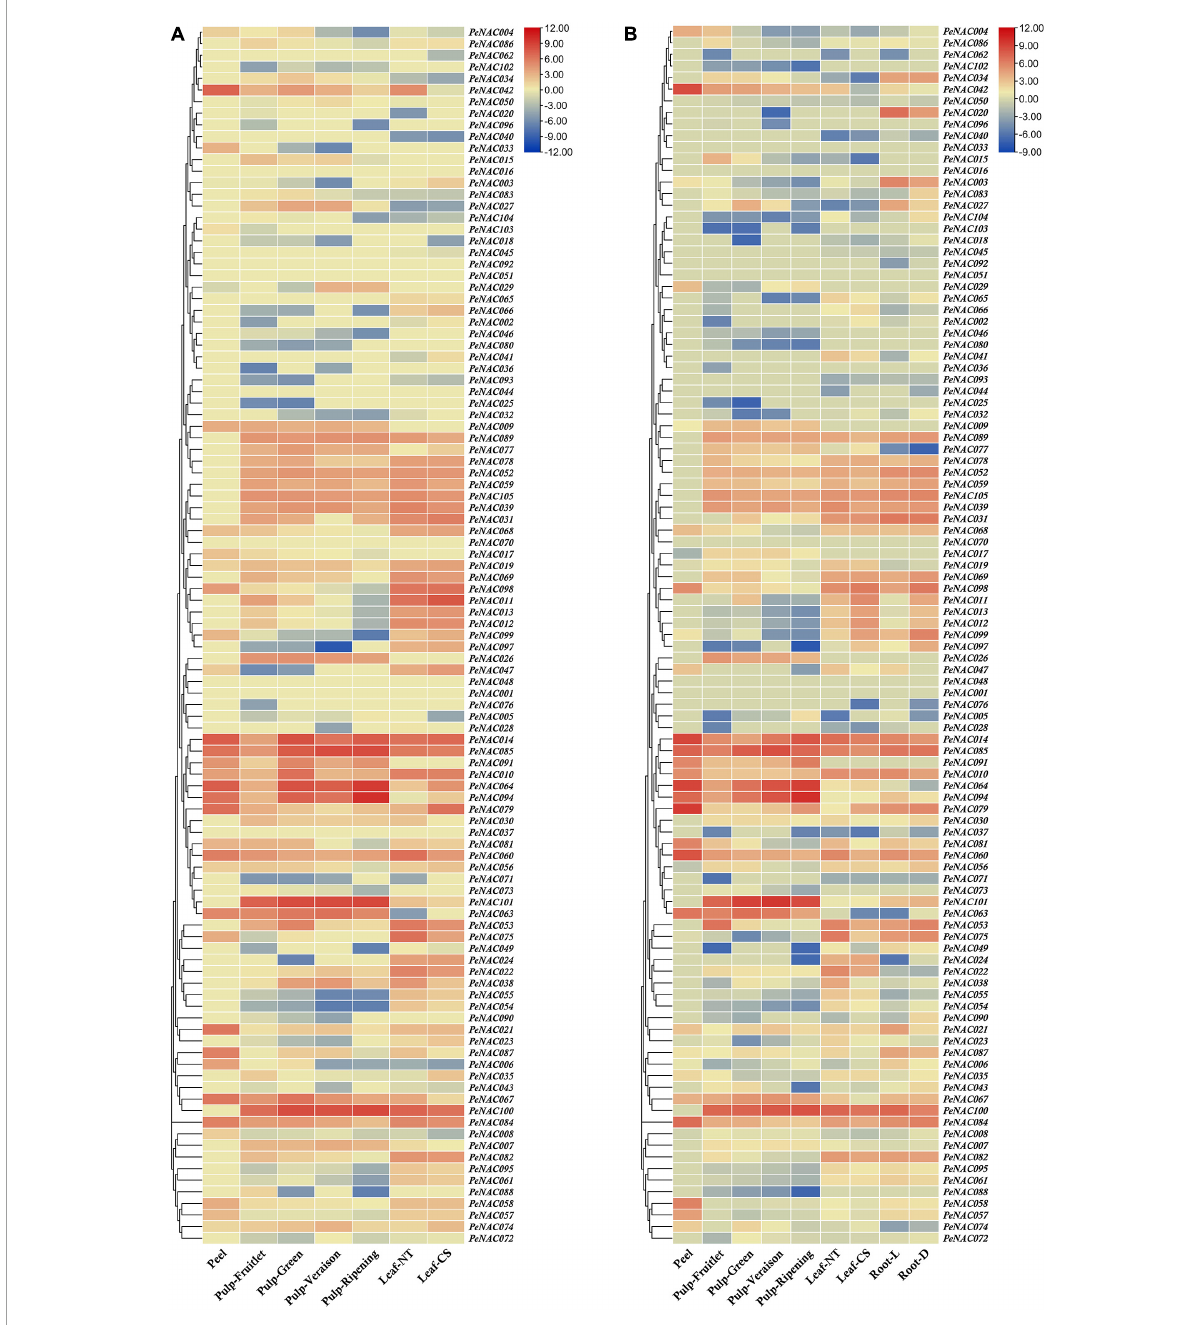
FIGURE10 The heatmap showing the expression profiles of PeNAC genes in pulp, root, peel, and leave tissues of yellow and purple passion fruit cultivars under different conditions. (A) PeNAC expressions in the peel, pulp (Fruitlet, Green, Veraison, and Ripening stages) and leaf (NT and CS) of yellow passion fruit. (B) PeNAC genes expressions in the peel, pulp (Fruitlet, Green, Veraison, and Ripening stages), leaf (NT and CS) and root (L and D). The NT and CS indicate the normal temperature (NT) and chilling stress (CS) conditions. L and D represent the samples from limestone (L) and sandy dolomite (D) rocky desertification areas. Fragments per kilobase per million (FPKM) values of PeNAC genes in all tissues were transformed by log2 and a heatmap was constructed by TBtools software (the red color shows the highest and the blue color shows the lowest expression levels in the expression